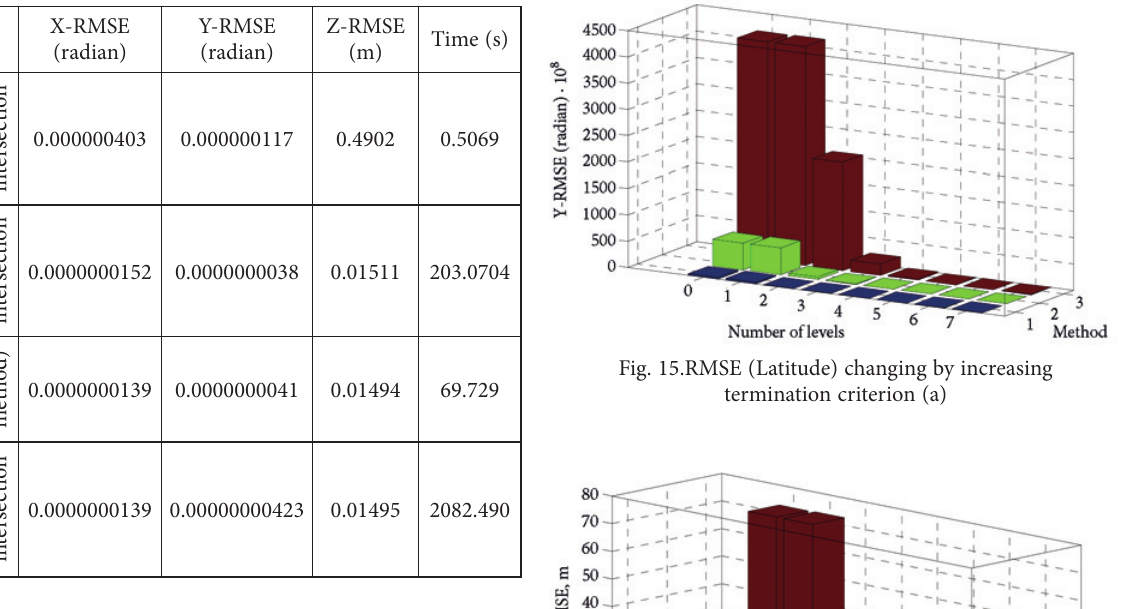
Table 1.RMSE for different methods of intersection.